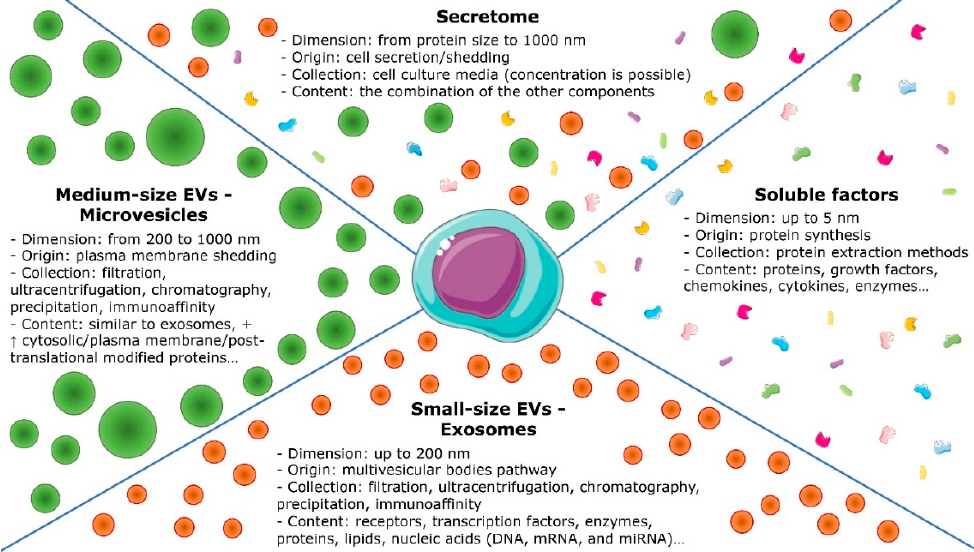
Figure 2. Schematic representation of secretome components.